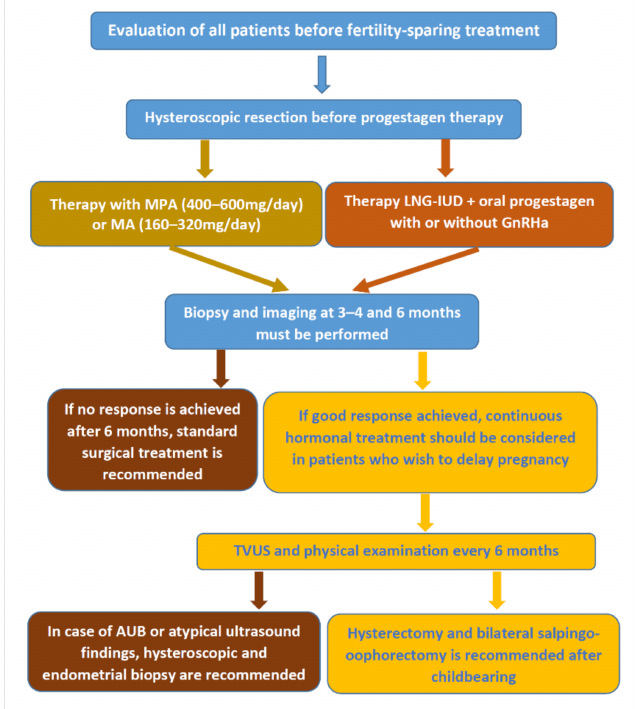
Figure 2. Fertility-sparing management for women with endometrial